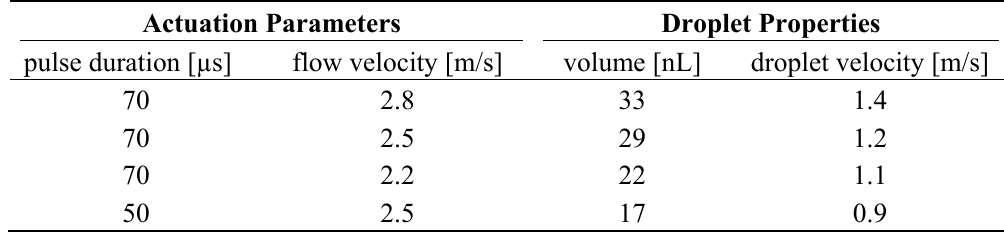
Table 2. Droplet dispensing process actuation parameters and resulting droplet